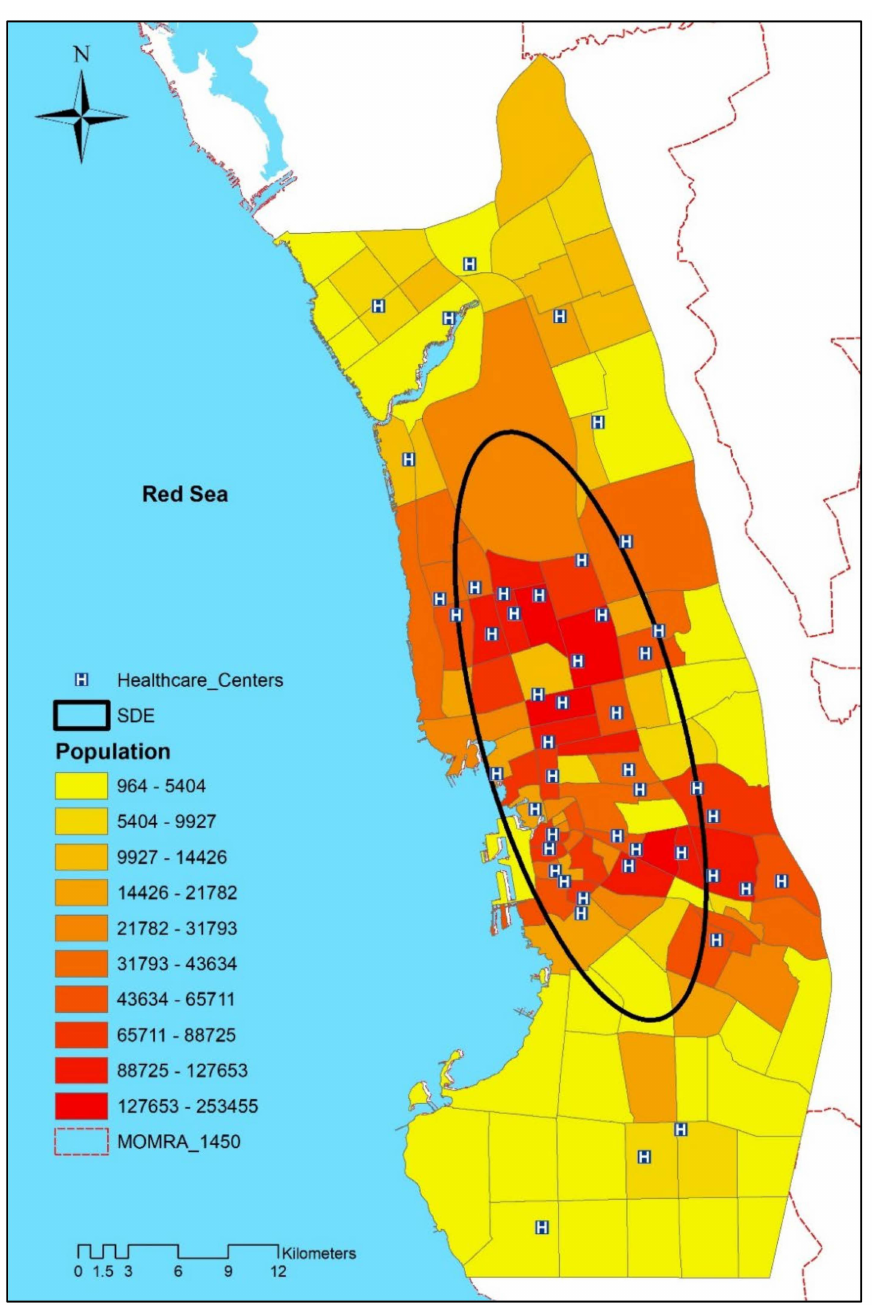
Figure 3. Standard deviational ellipse (SDE) for the spatial distribution of healthcare centers using ArcGIS